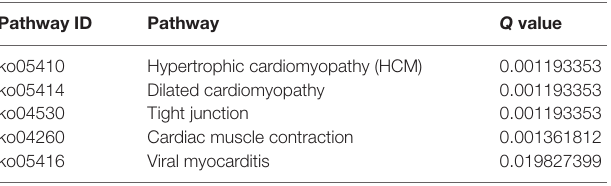
TABLE 3 | The significant enrichment analysis of target gene’s function in the pathway.